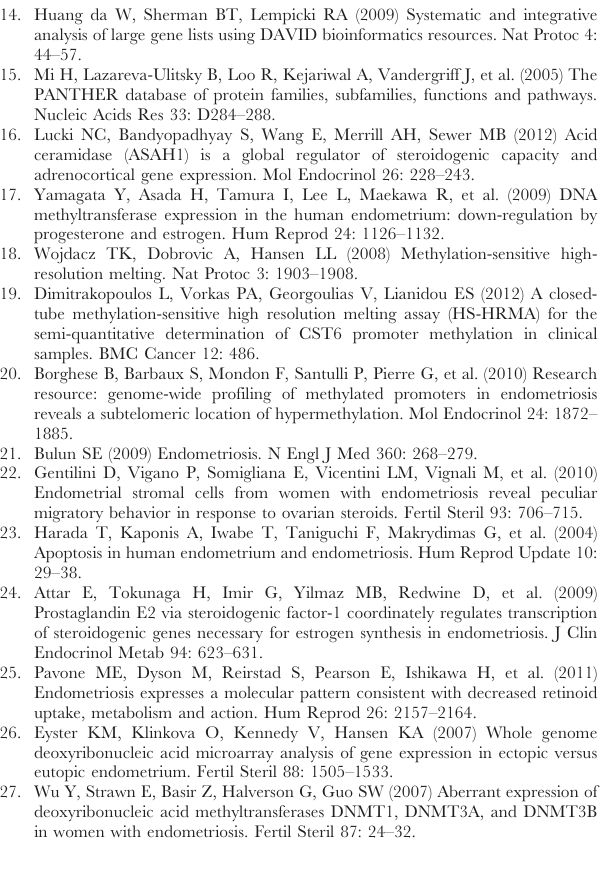
Table S7 Lists of genes that have significant hyper- methylated CpGs with significant high mRNA expres- sions in choESC compared to